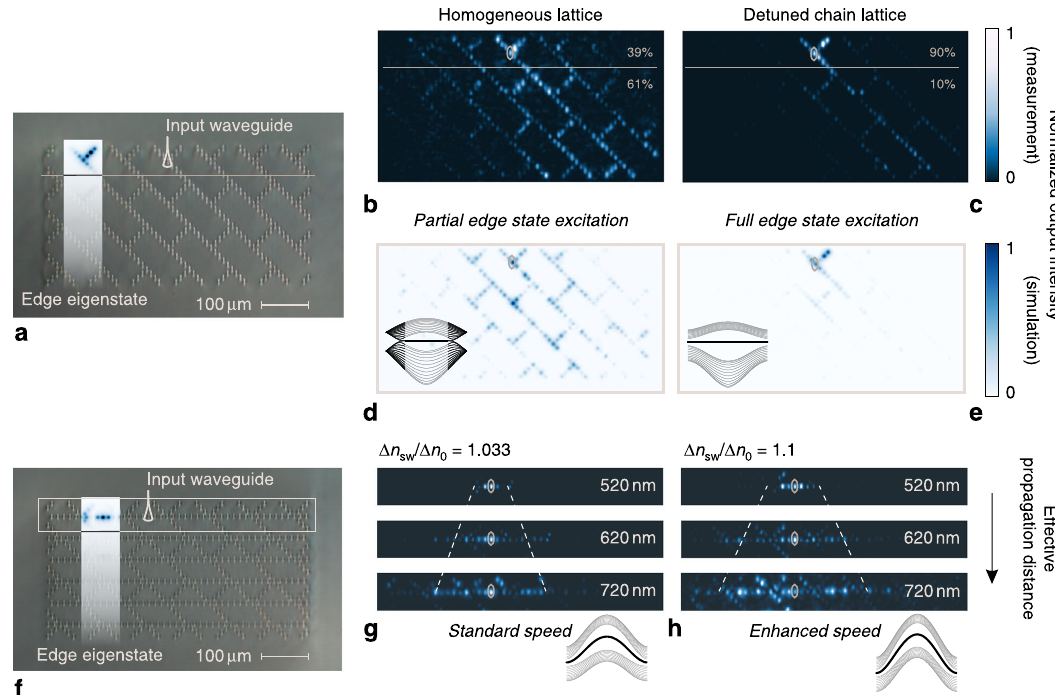
Fig. 3 Physical models and experimental results. a Micrograph of the three-chain lattices. The numerically calculated edge eigenstate is portrayed as overlay. b Observed distribution of light power at the end facet of the homogenous lattice. A considerable amount of power is leaked into the bulk. c Light power distribution for the lattice with a detuned chain. The edge mode occupies all k values and the edge state is excited almost exclusively. d , e Simulation results, obtained via the beam propagation method (BPM), for the two experimental lattices which demonstrate an analogous response. f Micrograph of the type-II lattice and the numerically calculated edge eigenstate. g , h Light power distribution at the edge for different wavelengths and different amounts of detuning ( Δ n sw / Δ n 0 ) for the secondary chains. The different probe wavelengths, effectively change the propagation distance within the physical sample. By adjusting Δ n sw , we modify the curvature of the edge-propagating modes and achieve higher group velocities that result in the observed spread of the pulse (for the respective simulation results see Supplementary Fig.